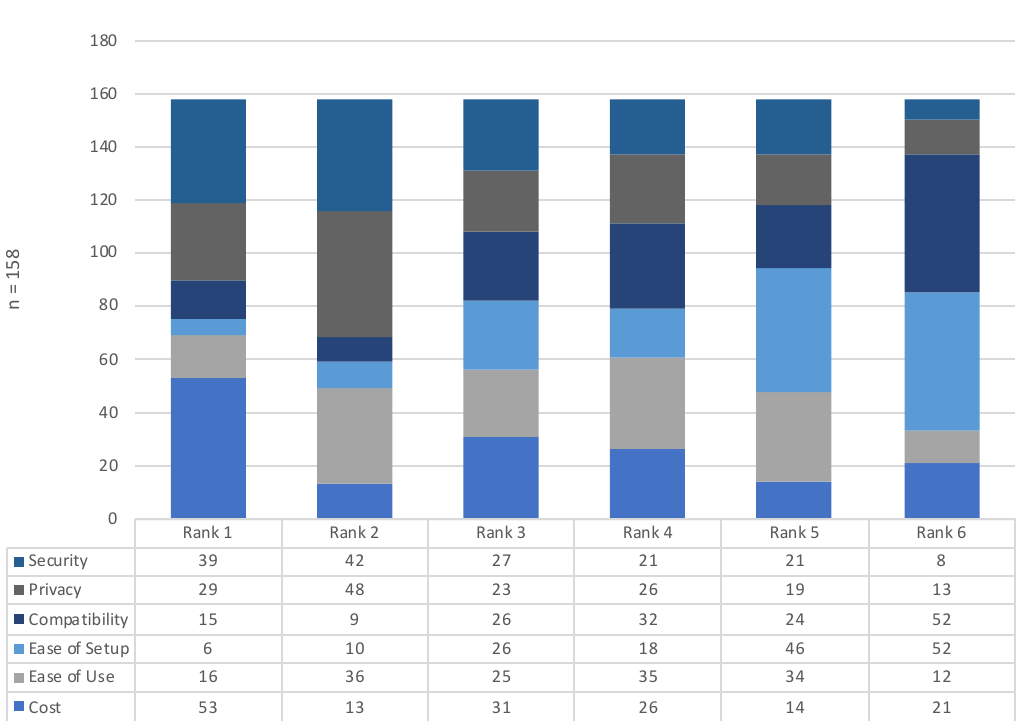
Figure 4. IoT device feature